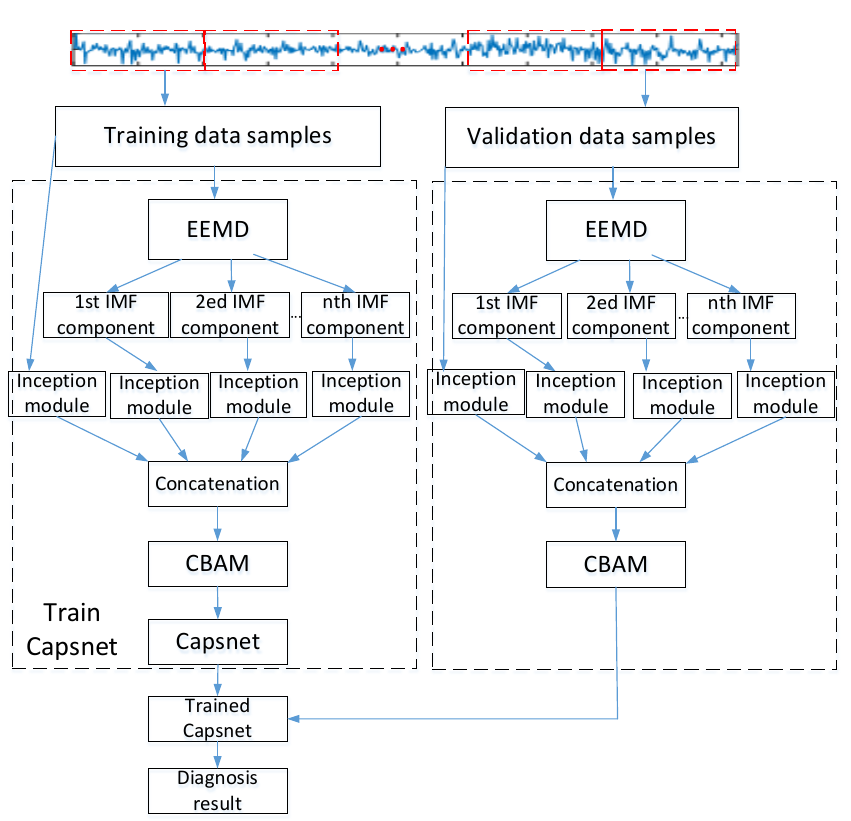
Figure 6. The diagnosis process of feature fusion based on Capsnet. In the training process of Capsnet, the margin loss function L k , depicted as Equation (15), is